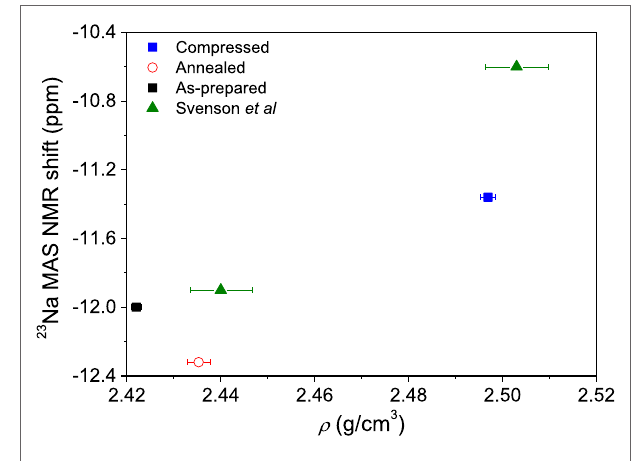
FigUre 13 | 23 na Mas nMr shift of as-prepared, compressed, and annealed glasses as a function of density ( ρ ) . Data are included from Svenson et al. (2014a) for glasses compressed at room temperature and 600°C.